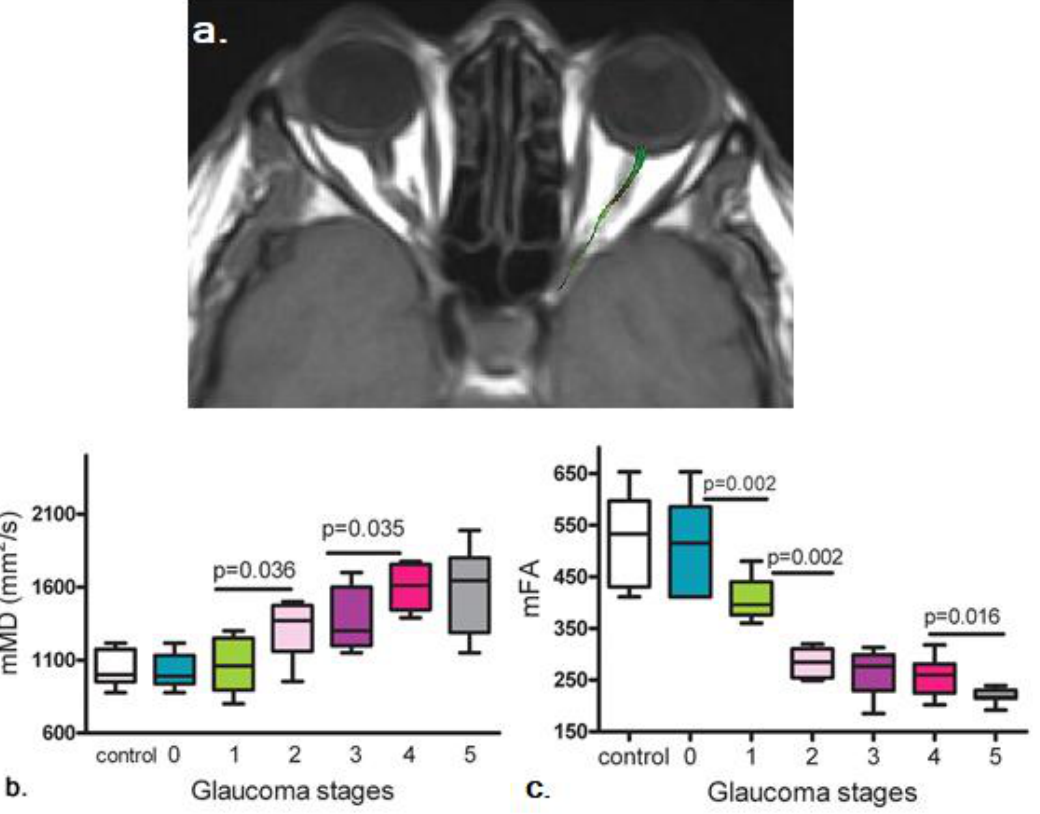
Figure 6. Changes in DTI parameters at different glaucoma stages. ( a ) Representative anatomical T1-weighted image from a 65-year-old male with severe glaucoma in the left eye (right side of image), with the optic nerve delineated by the green region of interest. Glaucoma progression is characterized by an increase in mean diffusivity ( b ) and by a decrease in fractional anisotropy ( c ) in the optic nerve. Glaucoma subjects were staged according to their visual field mean deviation score (MDS) as (0) increased intraocular pressure without visual field defects, MDS greater than 0 dB; (1) early, with an MDS between − 0.01 and − 6.00 dB; (2) moderate, with an MDS between − 6.01 and − 12.00 dB; (3) advanced, with MDS between − 12.01 and − 20.00 dB, (4) severe, with an MDS greater than − 20.01 dB; (5) end-stage glaucoma. Images are reproduced from Garaci et al.